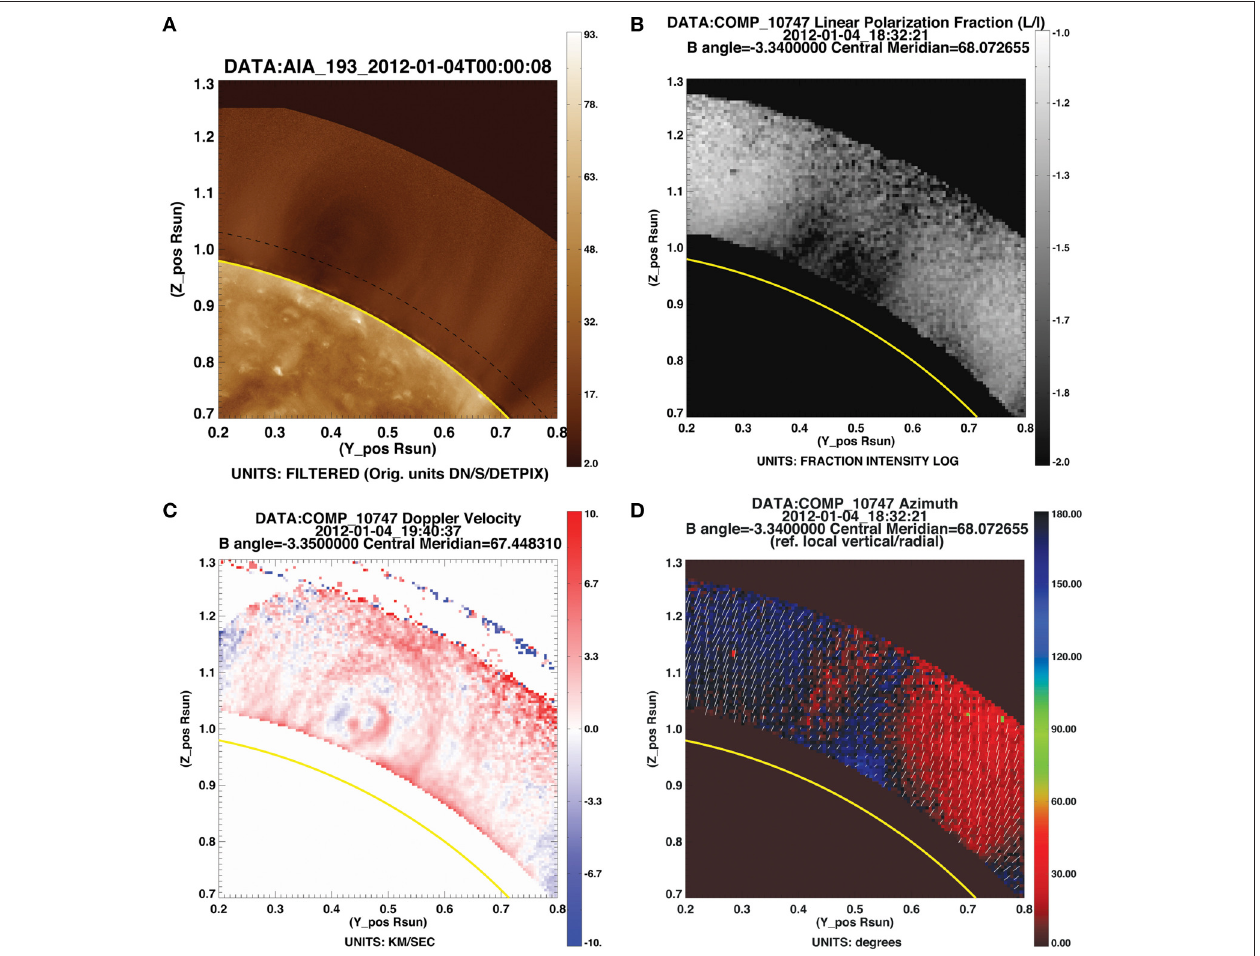
FIGURE 10 | Example of FORWARD -displayed data products for a coronal cavity. (A) SDO/AIA 193 Angstrom. Plot obtained via widget as described in the text, or through IDL line command for_plotfits,date='2012-01-04',/aia,xxmin=.2,xxmax=.8,yymin=.7,yymax=1.3,occult=-1.05, upoccult=1.29 . (B) CoMP fraction of linearly-polarized light L / I . Plot obtained via widget and utilizing moreplots option as described in the text, or command as in (A) substituting /comp for /aia , removing occult and upoccult keywords, and adding line='LoI',imin=-2.,imax=-1 . (C) CoMP Doppler velocity (partially corrected for solar rotation Tian et al., 2013). Plot displays data from CoMP Dynamics fits file downloaded from MLSO web page (http://www2.hao.ucar.edu/ mlso), through widget “By File” option or command as in (A) substituting /comp , removing date and occult, upoccult keywords, and adding filename='20120104.194037.comp.1074.dynamics.3.fts',line='DOPPLERVLOS' . (D) CoMP linear polarization azimuth. Plot obtained by widget or command line as in (A) , but substituting /comp , and adding line='Az'